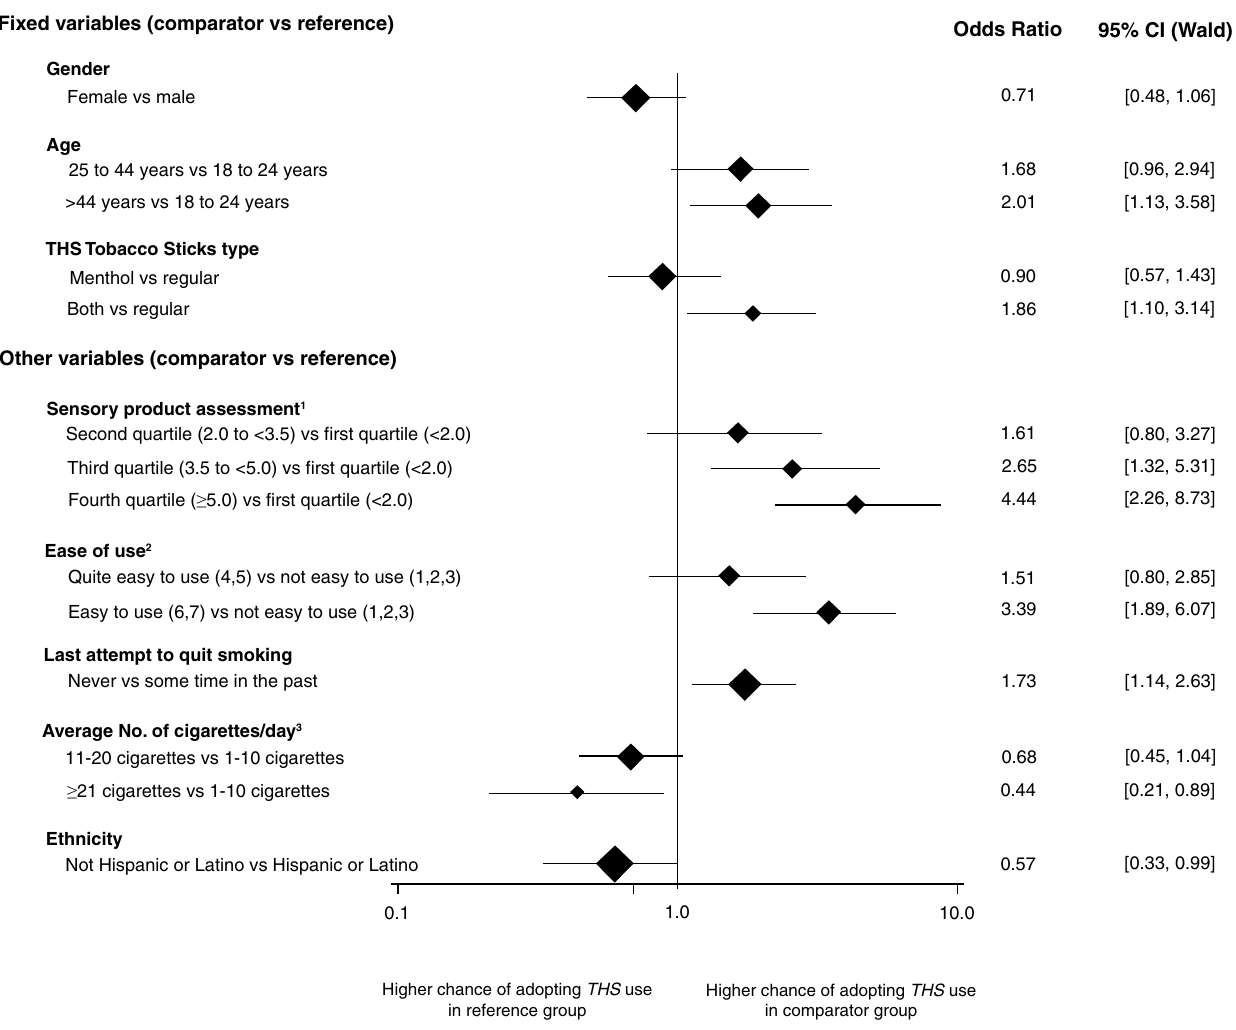
Figure 2. Predictors of adoption of THS at the end of the observational period. The vertical line shows the value where chances of adopting are equal in both the reference and the comparator group. Horizontal lines show the confidence intervals. The size of the diamonds is proportional to the number of participants in the comparator group. 1 The taste, smell, and aftertaste of the product were assessed using seven-point scales ranging from 1 = “I don’t like it at all” to 7 = “I like it very much”. For the scale assessments, Cronbach’s alpha was calculated as measure of internal consistency among the scales. Because of an alpha of 0.89 (above the threshold value of 0.8), a combined construct of sensory acceptance was calculated using the mean scale assessments over taste, smell, and aftertaste. Four categories were created based on the quartiles of the distribution of these mean scale assessments. 2 Ease of use of the product was assessed using a seven-point scale ranging from 1 = “not easy to use at all” to 7 = “very easy to use”. 3 Average number of cigarettes/day at